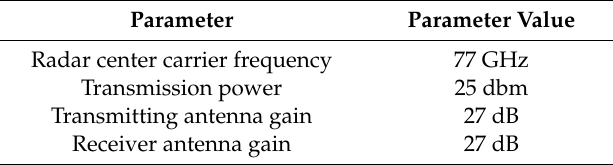
Table 3. Radar parameter settings in highway scene with heavy rain.